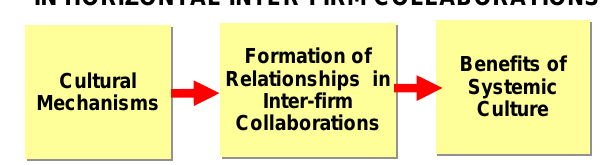
Figure 1. “Theoretical framework of cultural mechanisms in